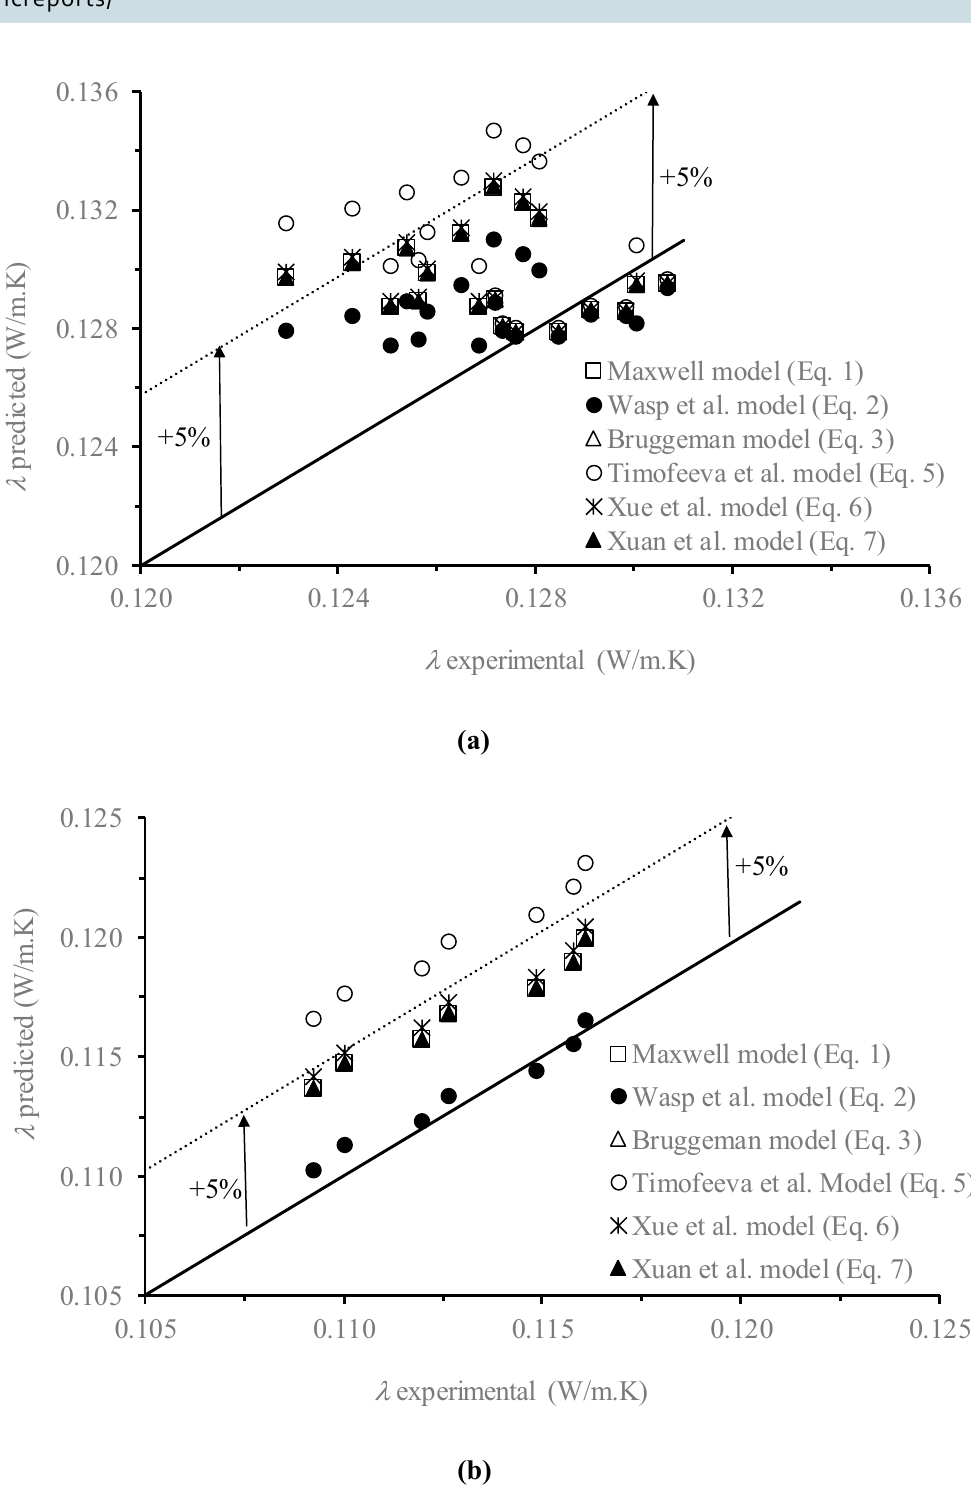
Figure 3. Predicted λ of C 60 NFs based C 10 H 12 ( a ) and in C 6 H 4 Cl 2 ( b ) vs. the obtained experimental λ values. Microsoft Excel 2016 was used to generate these